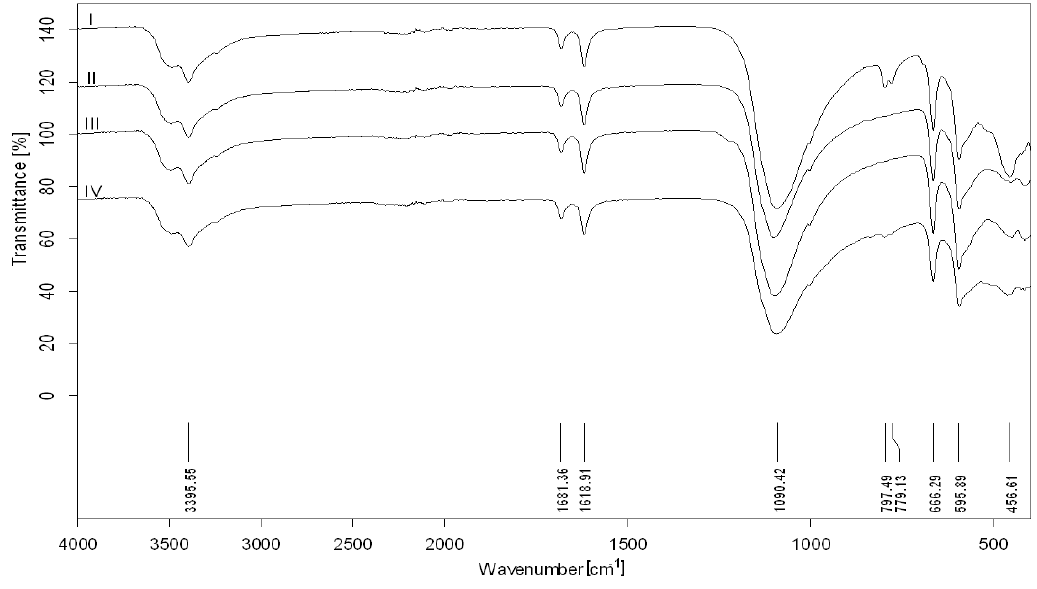
Figure 3. Infrared spectra of phosphogypsum (terraces I–IV).